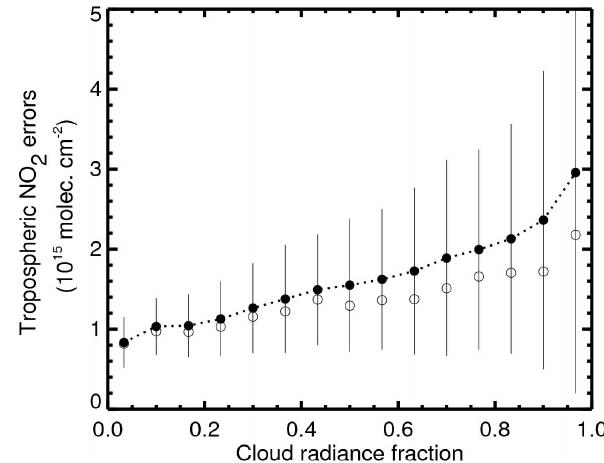
Fig. 4. Mean tropospheric NO 2 vertical-column errors (solid cir- cles) as a function of cloud radiance fraction, based on SP2 data from 21 March 2005. Vertical lines show error standard deviations and open circles indicate median